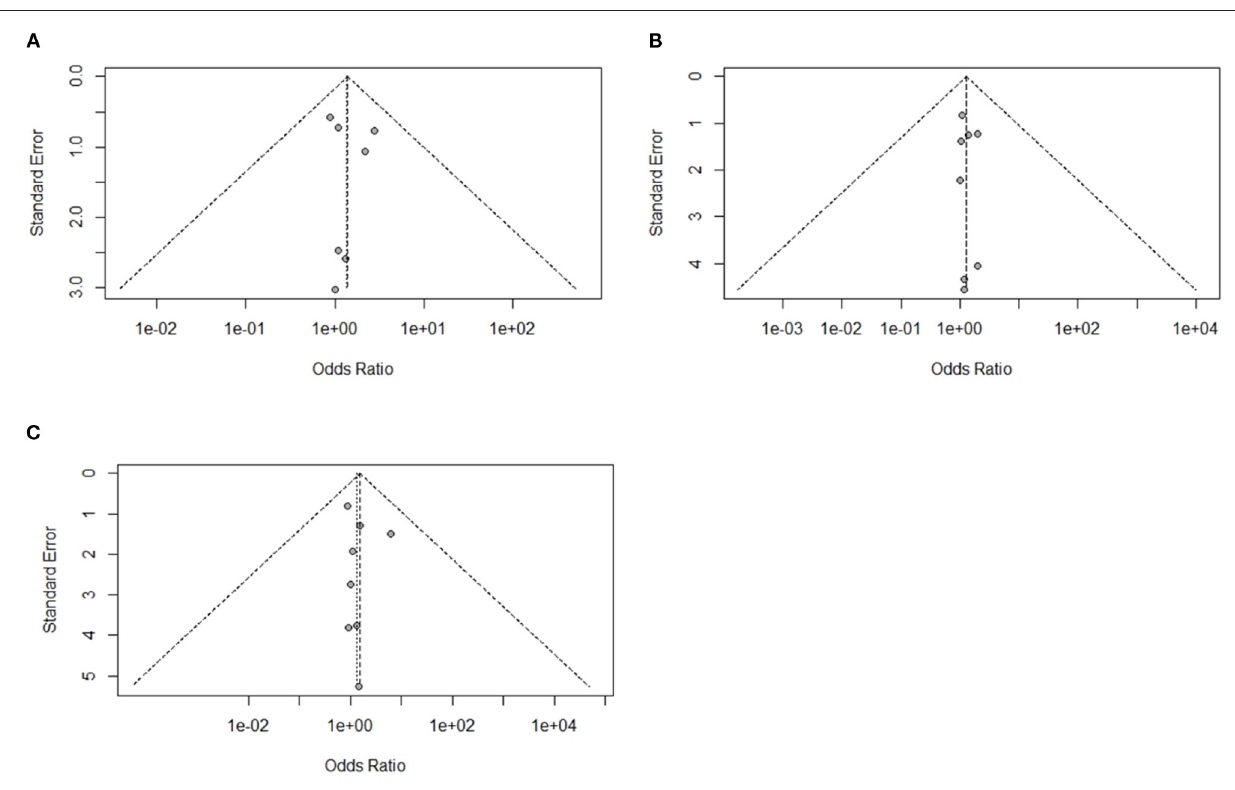
Frontiers in Physiology |